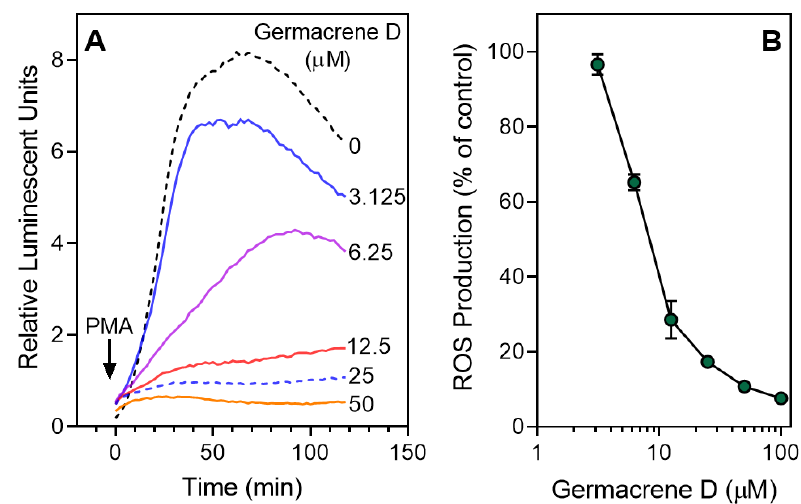
Figure 6. Inhibition of PMA-stimulated neutrophil ROS production by germacrene D. ( A ) Neutrophils were treated with 1% DMSO (negative control) or the indicated concentrations of germacrene D. After 10 min of preincubation, the cells were activated with 200 nM PMA (indicated by an arrow), and ROS production was monitored using an L-012-amplified assay system. ( B ) Relative integrated luminescence (120 min) is shown as the luminescence ratio normalized to background (1% DMSO) and plotted against germacrene D concentrations. The data are presented as the mean ± S.D. (N = 3) from one experiment. For both panels, a representative experiment from three independent experiments is